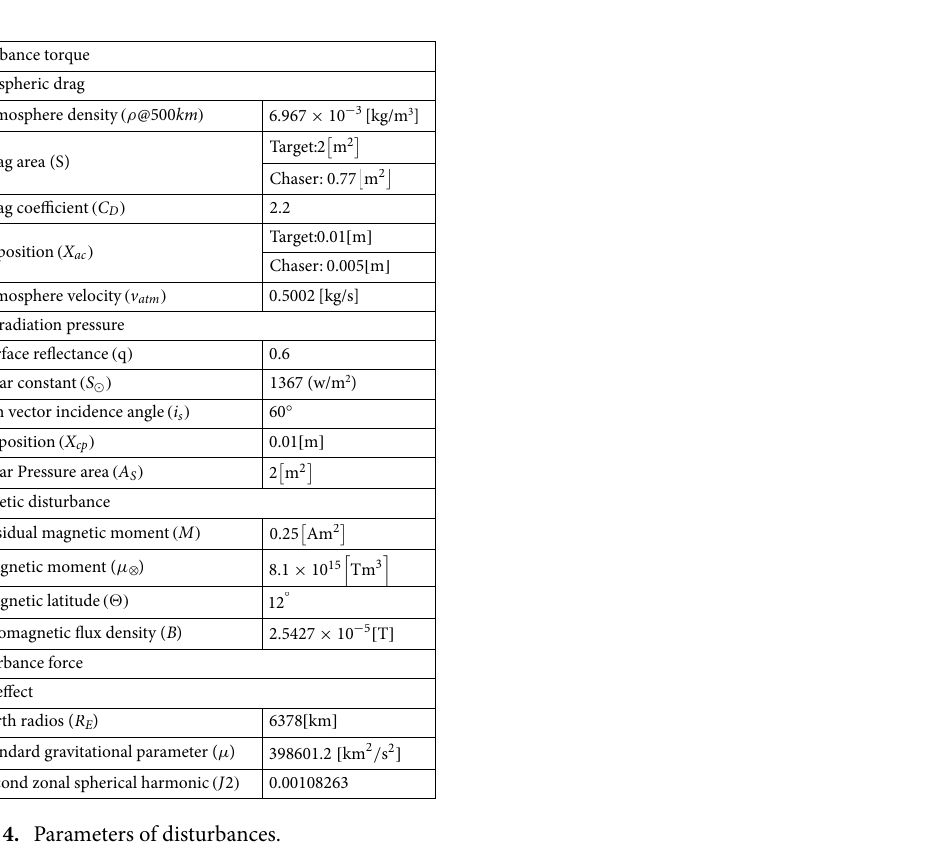
Table 4. Parameters of